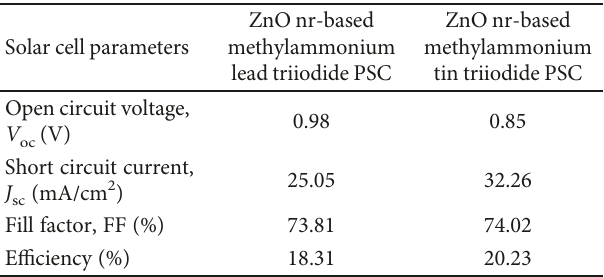
Figure 10: Device structure of methylammonium lead triiodide ZnO nanorod-based PSC and Pb-free ZnO nanorod-based PSC. Table 6: I - V characteristics of methylammonium lead triiodide PSC and Pb-free ZnO nanorod-based